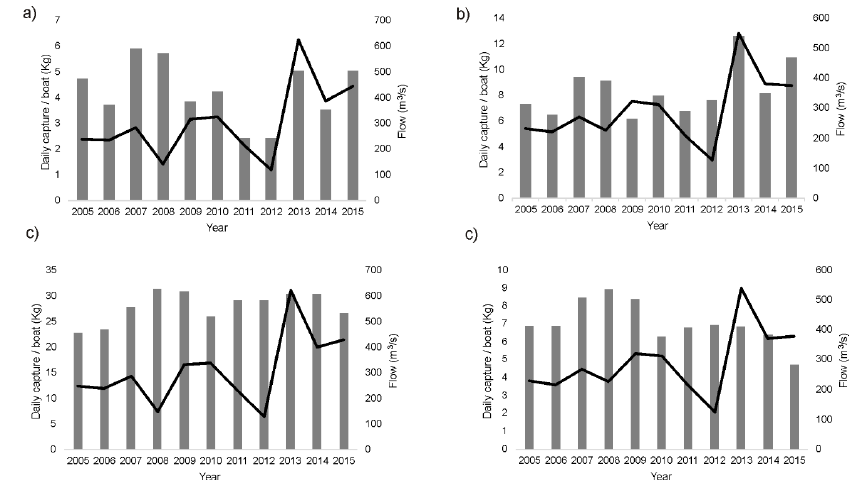
Figure 5. Annual average captures by number of boats (columns, first axis) and flows (line, secondary axis) and for the fishery species selected and the two techniques used: ( a ) Prawn and trawling, ( b ) prawn and other techniques; ( c ) mantis shrimp and trawling; and ( d ) mantis shrimp and other techniques.